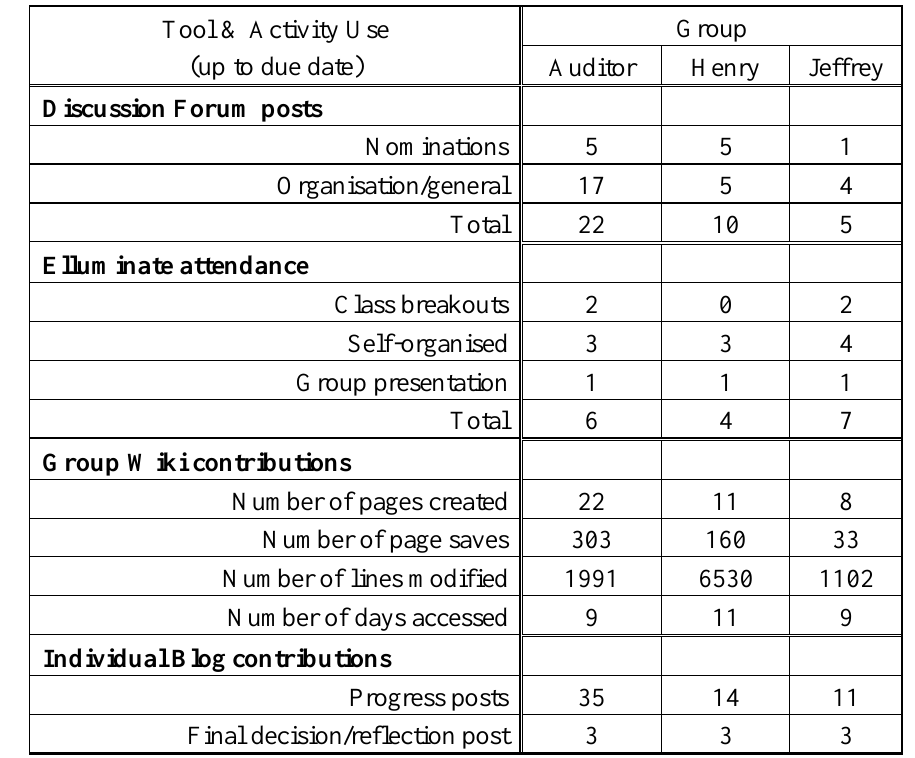
Table 3. 2008 Grey Paints Case Group Activity